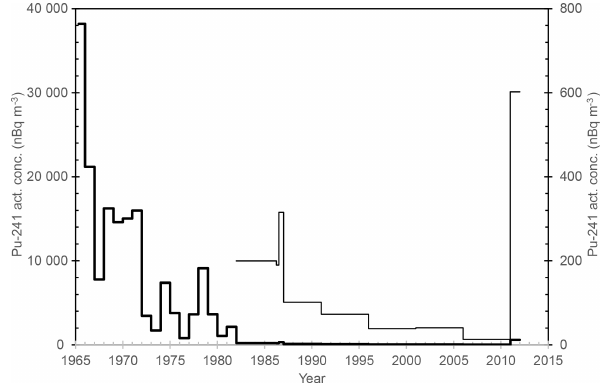
Figure 3. The activity ratio of 238 Pu / 239 + 240 Pu in the surface air of Rovaniemi as a function of